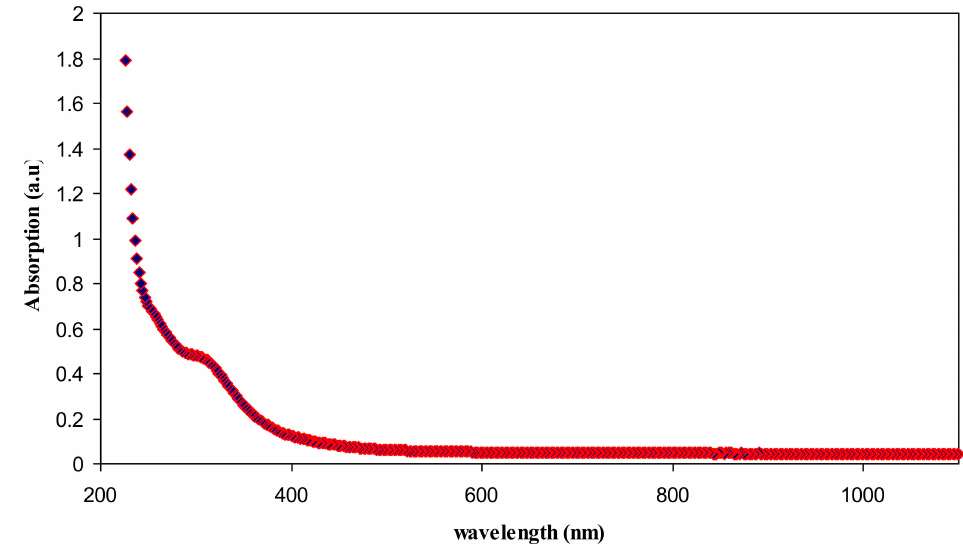
Figure 8. Absorption spectra of pure chitosan.